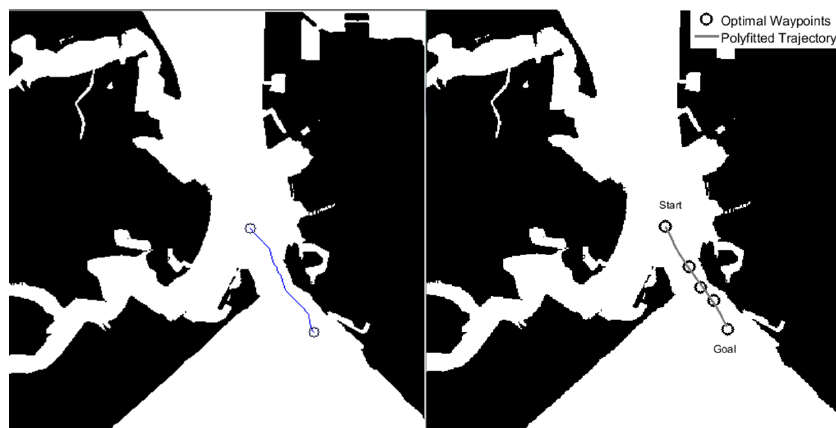
Figure 10. Generated ( left ) and smoothed trajectory ( right ) from the optimal waypoints produced by the path planner. Binary map of 800 × 800 resolution is considered for the current study with one pixel representing 3.6 m on a real